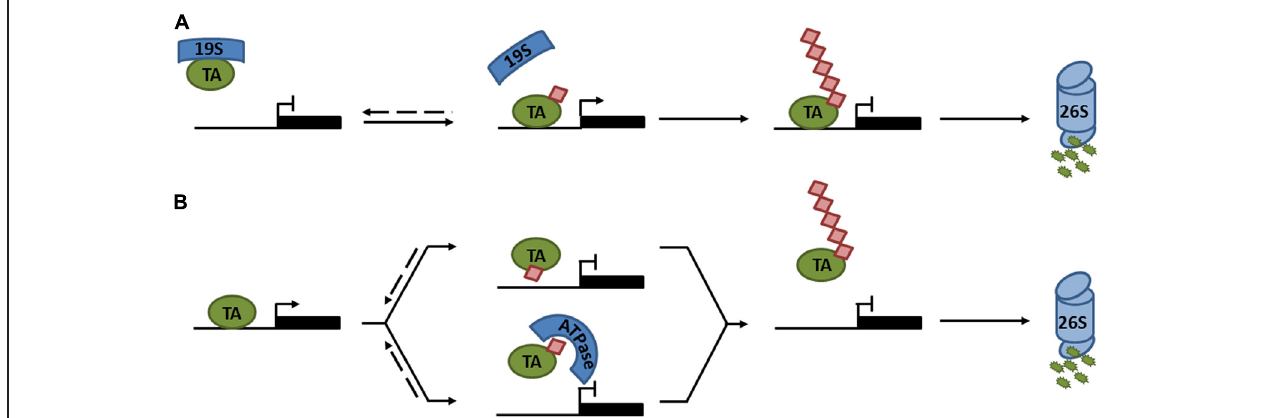
FIGURE 2 | Regulation of transcription activator activity by monoubiquitination. (A) The 19S proteasome subcomplex binds an unmodified transcription activator (TA), preventing it from associating with its target promoter. Monoubiquitination of the TA disrupts association with the 19S subcomplex, allowing the TA to bind its target promoter and activate gene expression. Subsequent polyubiquitination marks the TA for